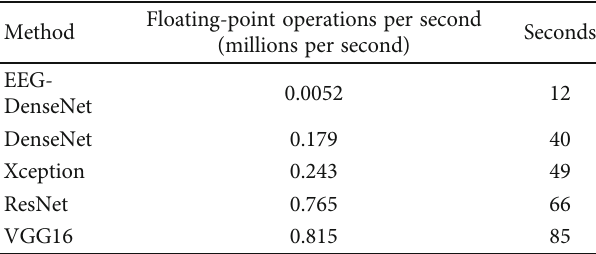
Table 8: Floating-point operations per second and training CPU time of classi fi cation all methods.